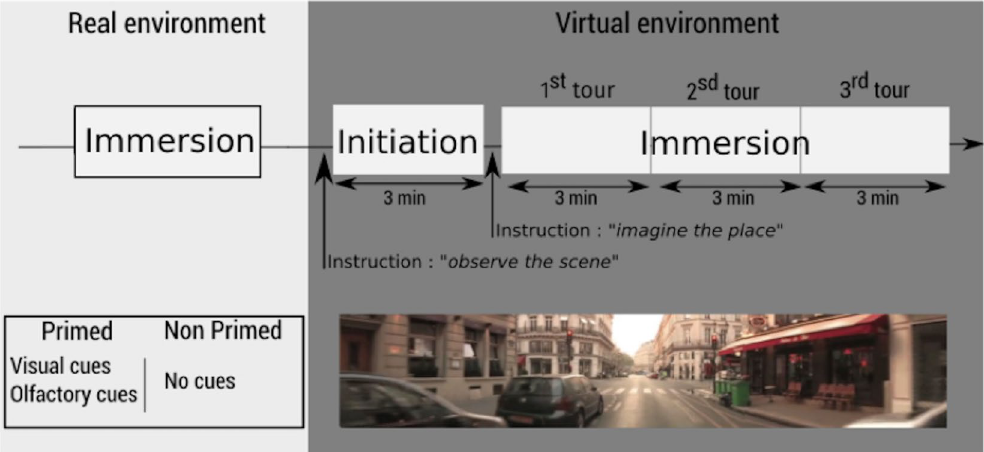
Figure 3. Schematic representation of the experimental procedure and naturalistic virtual environment 41–44 . Participants have been through immersion into real environment (ImRE), initiation into virtual environment (InVE) and immersion into virtual environment (ImVE). “Primed" and “non primed” participants had been immersed into the real environment “with” primes and “without” primes respectively. Each participant performed three consecutive tours when immersed into the virtual environment